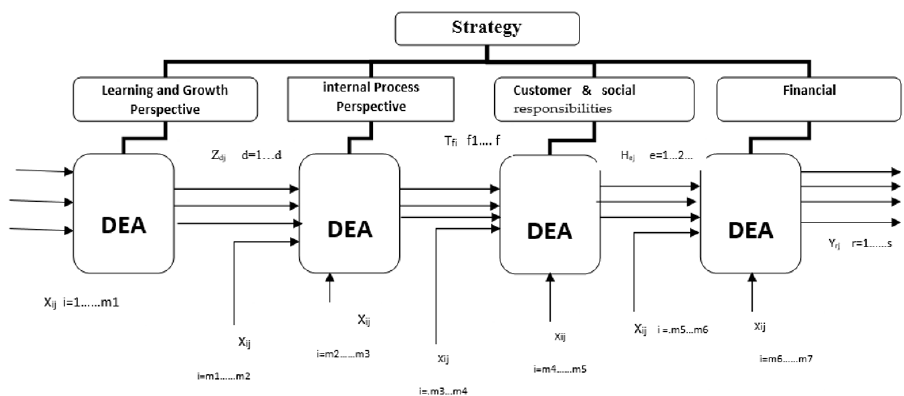
Figure 9. The network structure of the issue based on the BSC aspects.